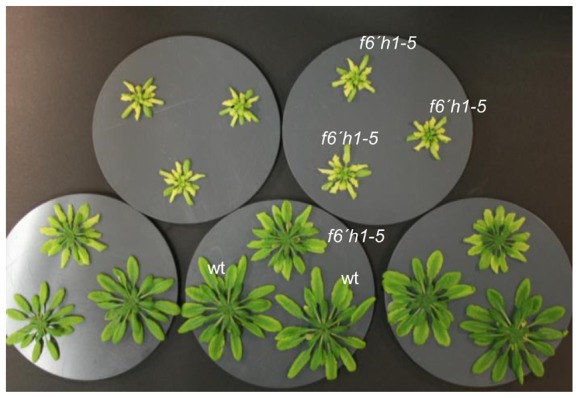
Partial rescue of the f6′h1-5 growth defect in alkaline medium by co-cultivation with wild-type plants.
F6′H1 knock-out plants (f6′h1–5) were co-cultivated for four weeks in alkaline Hoagland’s solution (pH 7.7) either with plants of the same mutant genotype (top row) or with A. thaliana Col-0 plants (wt) (bottom row). Experiments were repeated three times independently with nearly identical outcome.